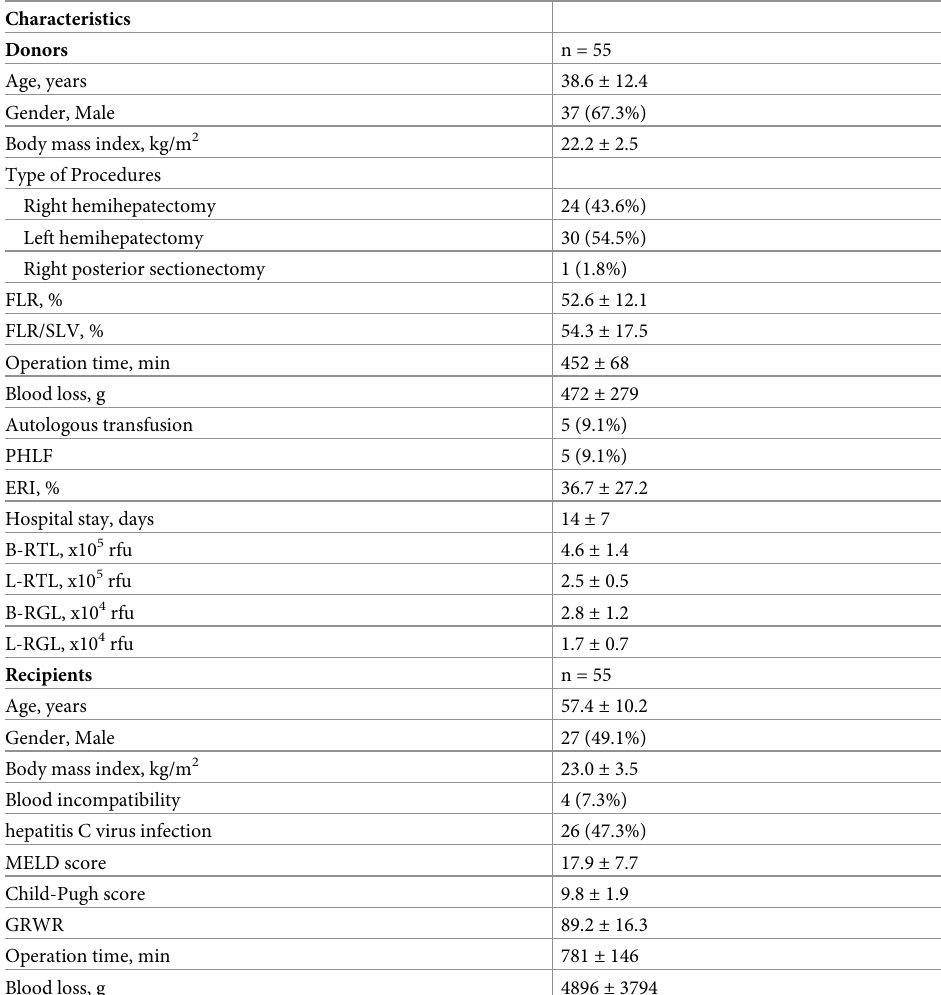
Table 1. Clinical characteristics of patients.